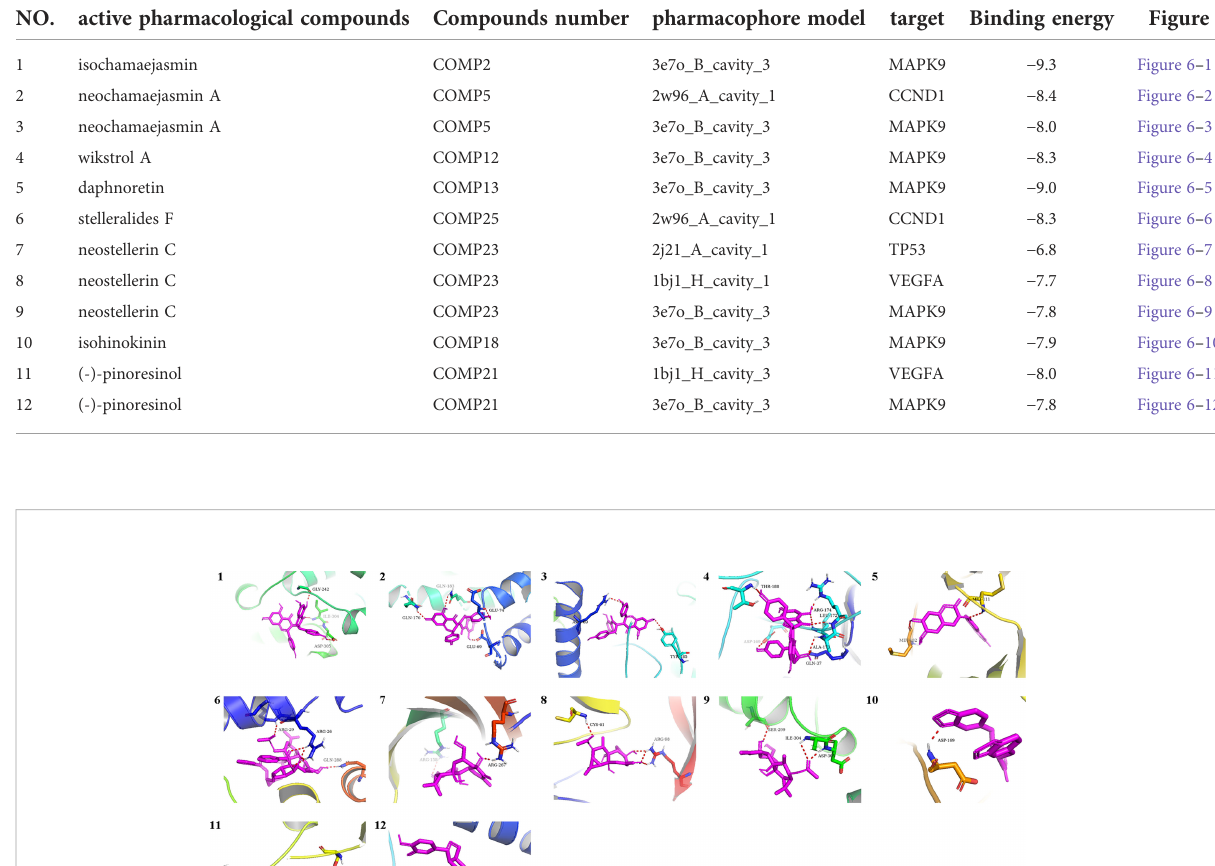
TABLE 3 The docking results of core RXLD pharmacological compounds and related GBM